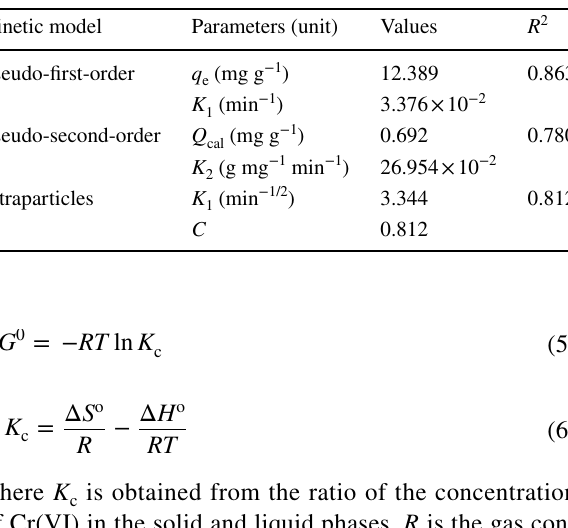
Table 2 Summary of parameters for various kinetic models of Cr(VI) adsorption by GO